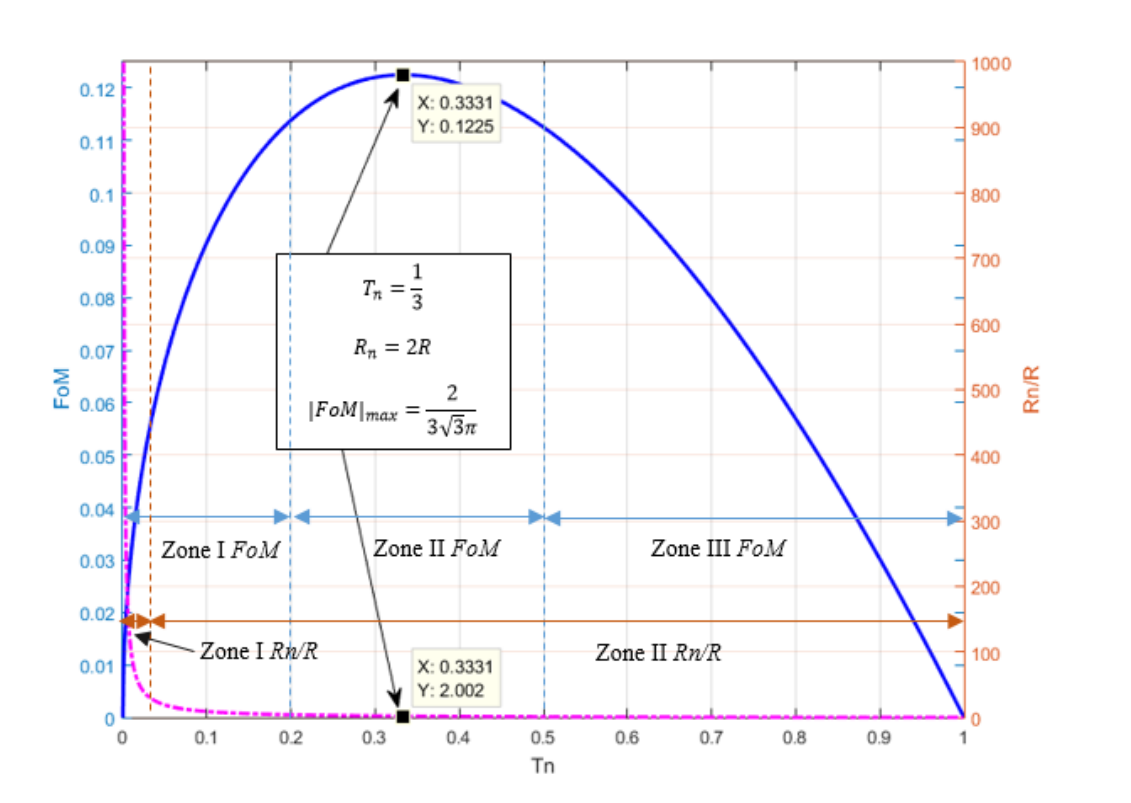
FIGURE 4. FoM n and R n /R ratio variations vs T n